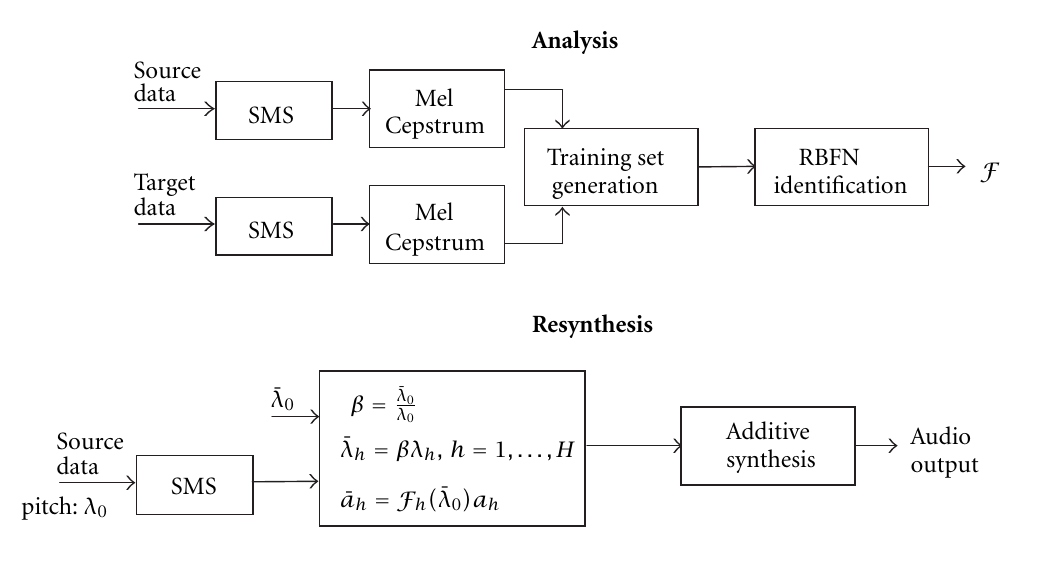
Figure 2: Block diagram of the analysis-resynthesis schema. The steps in the analysis task are: (1) representation of the source and target data by a mel-cepstrum based sinusoidal representation, (2) generation of a training set of conversion patterns, and (3) computation of the parameters of the RBFN model which represents the conversion function. The re-synthesis task requires: (1) to represent the source data by a sinusoidal model, (2) to compute at each frame the spectrum transformation, using the conversion function to compute the amplitude of partials, and (3) to synthesize frames by mean of additive synthesis or inverse-Fourier transform. Note that no mel- cepstrum representation is involved in the re-synthesis process, since the spectrum transformation is directly applied to the sinusoidal